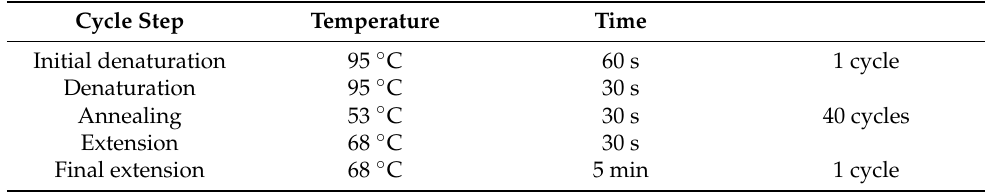
Table 2. Cycling protocol for methylation